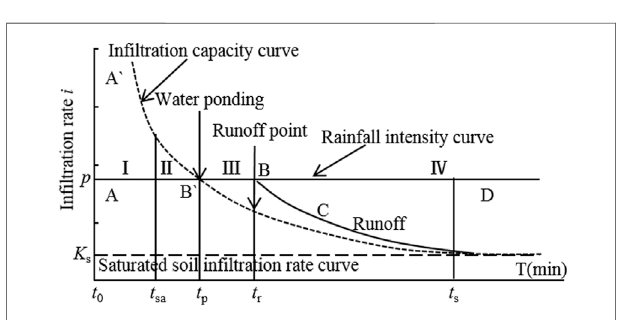
FIGURE 3 | The curve of soil in fi ltration rate changes with time during a rainfall event (Mein and Larson 1973).